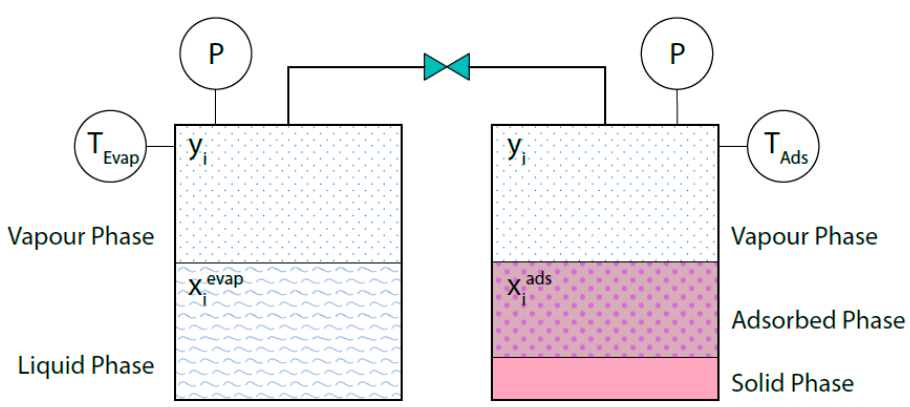
Figure 2. Phase equilibria in the evaporator (or condenser) and in the adsorption bed. At the thermodynamic equilibrium y i and P are the same in the two vessels.